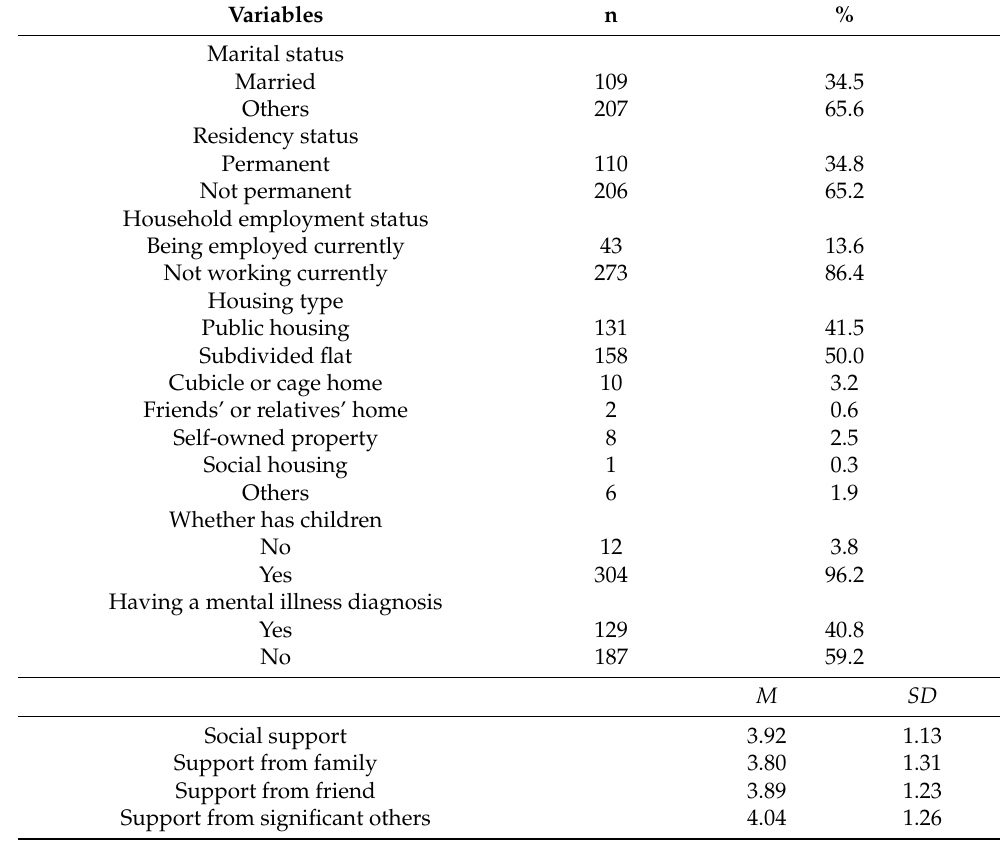
Table 1. Demographic Characteristics of Participants and Social support.